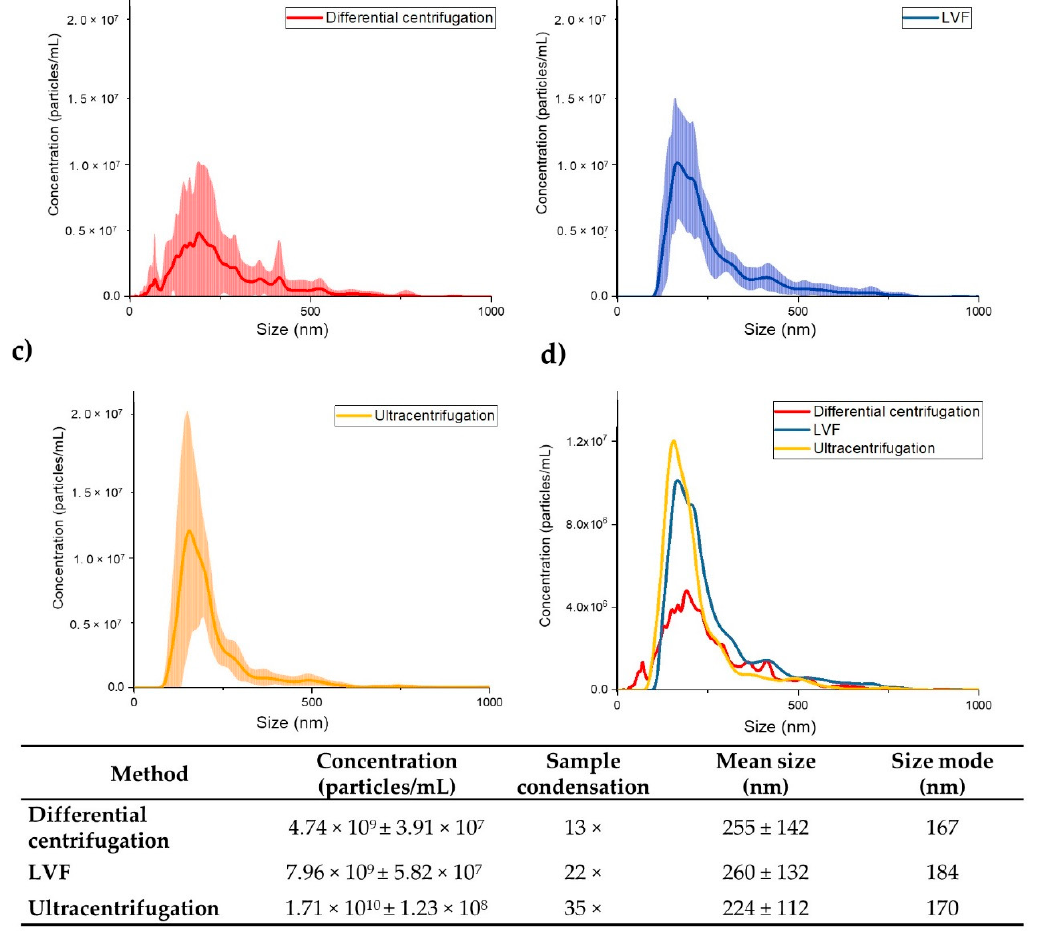
Figure 5. Results of the Nanoparticle Tracking Analysis (NTA). ( a ) Di ff erential centrifugation; ( b ) LVF; ( c ) Ultracentrifugation; ( d ) Comparison of the isolation methods tested. The lines indicate the mean concentrations (line) of the three samples. Each sample was recorded for 30 s and the measurement was repeated 5 times. The SDs of the three independent measurements are presented as the colored areas around the mean concentration line. The table presents the average concentrations of EVs in the samples after isolation; sample condensation, defined as the relative increase in the number of EVs in the sample after isolation compared to their concentration in the starting samples; the average EV diameter; and the size